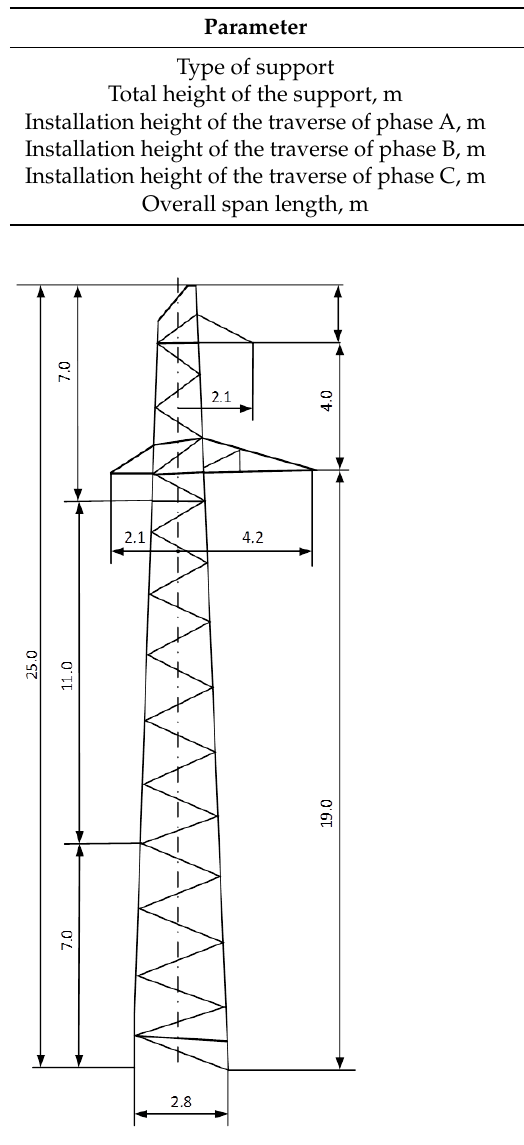
Figure 24. Steel intermediate support of 110 kV overhead line.